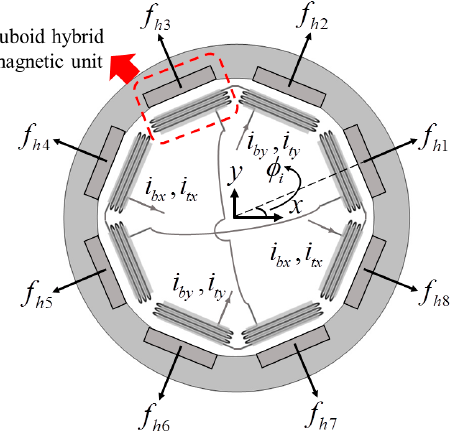
Figure 7. An octagon structure with eight hybrid magnetic units.